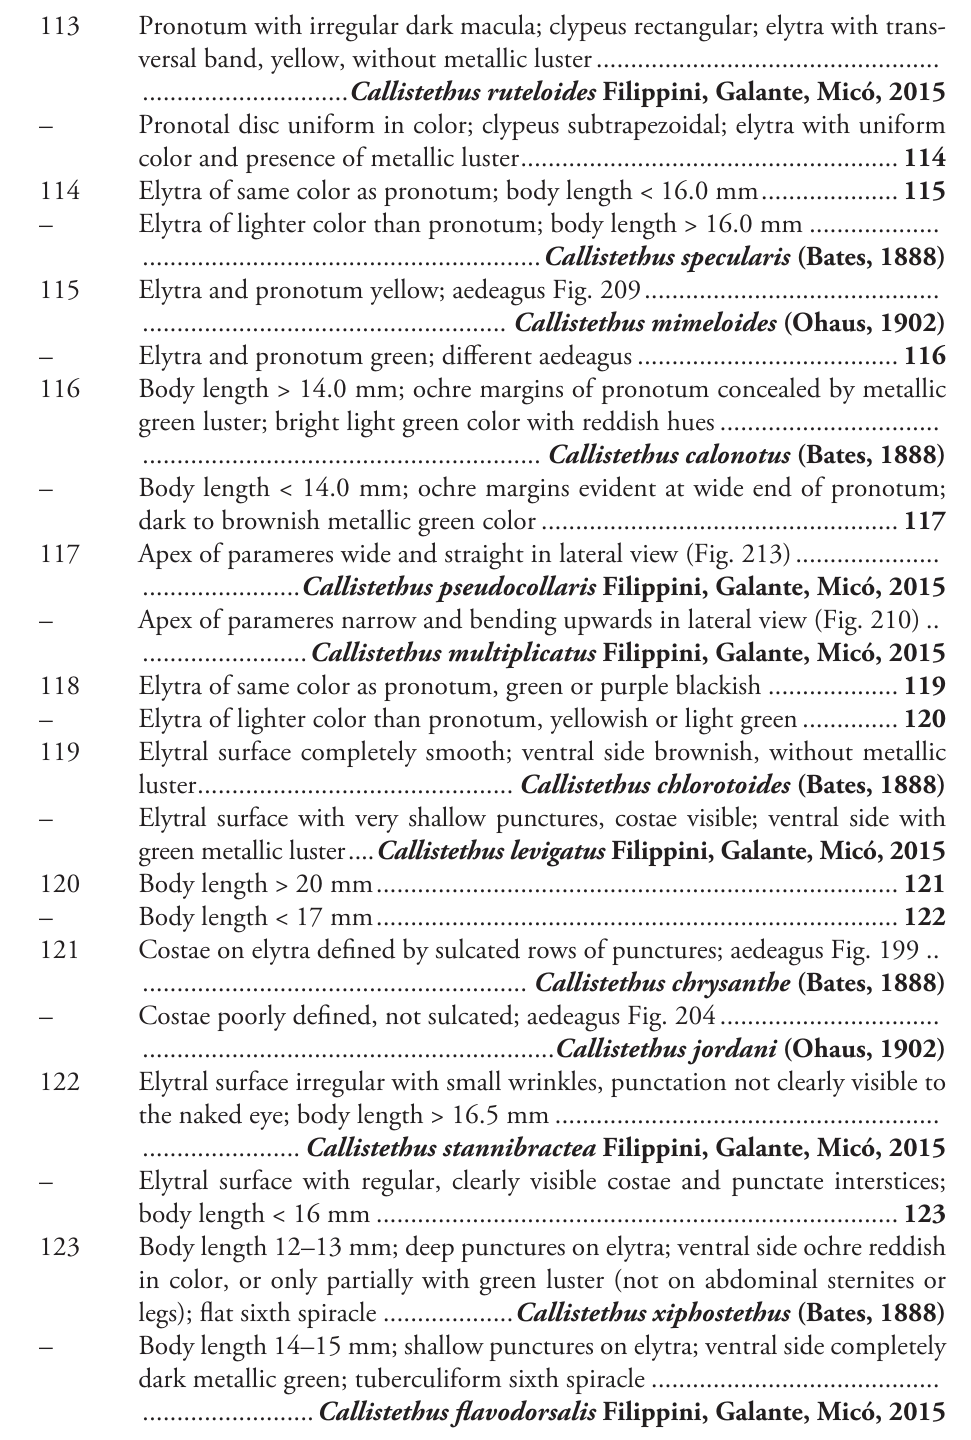
Pronotum with irregular dark macula; clypeus rectangular; elytra with trans-